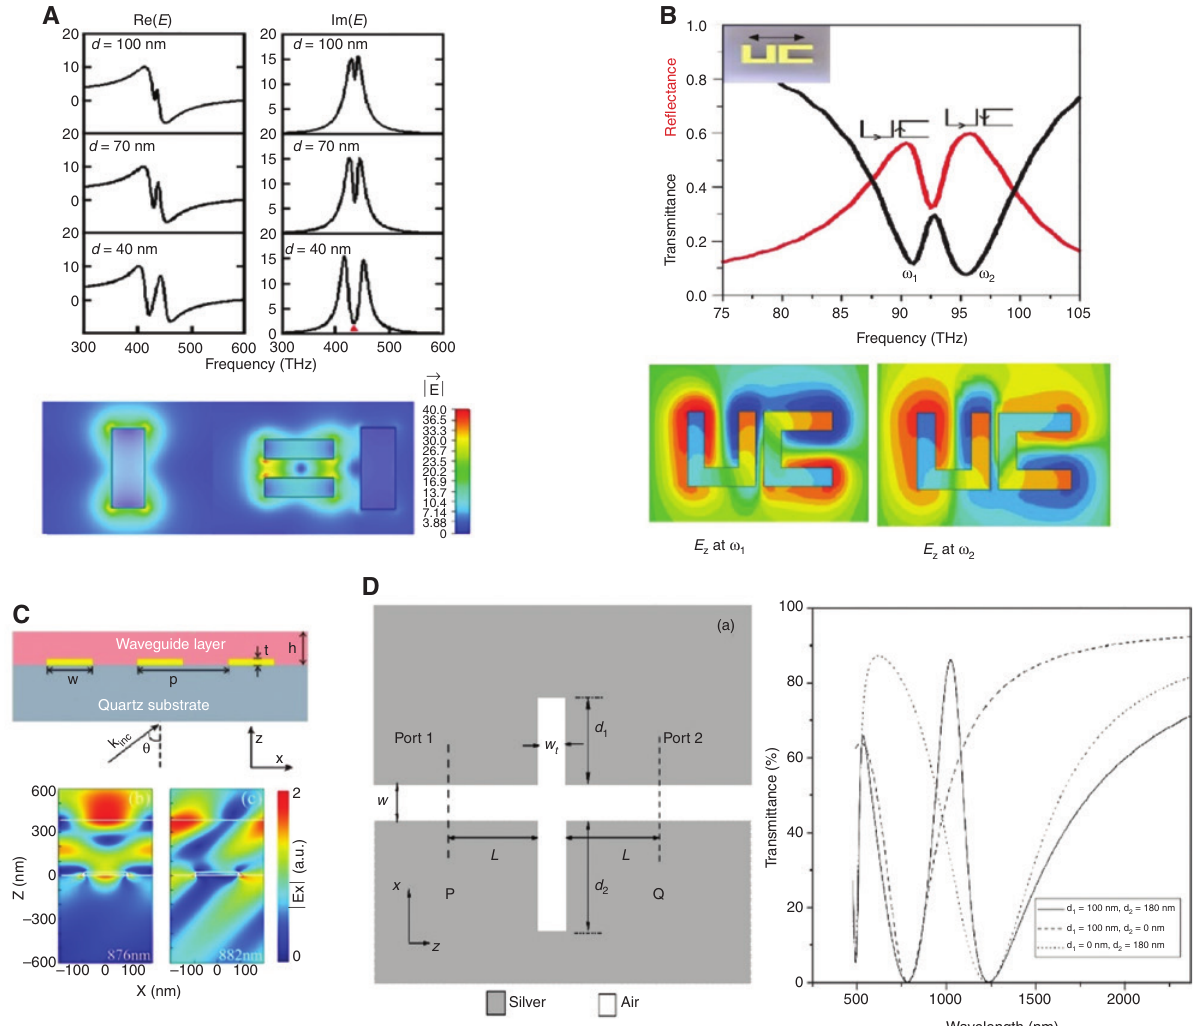
Figure 1: Transmission spectrum and near-field distribution of the PIT effect. (A) A π -shaped structure containing metal nanorods as building blocks. The real and imaginary parts of the electric field spectra indicate that PIT phenomena can be tuned by changing the gap distance between bright and dark resonators. The 2D field plot of electric field distribution indicates the bright and dark modes [24]. (B) Asymmetric SRRs supporting magnetoinductive or electroinductive coupling. Simulated transmittance and reflectance spectra of the asymmetric SRRs indicate a PIT transparent window at 93 THz. The electric field distributions at resonances ω and ω of the PIT structure are also provided [25]. (C) Schematic illustration of the hybrid PIT structure 1 2 illuminated by a light with an incident angle of θ . The simulated field distributions at PIT range indicate the metallic nanogratings and the dielectric cover layer provide the bright and dark modes, respectively [26]. (D) Schematic of an in-plane coupling PIT structure composed of double-sided teeth-shaped nanocavities and plasmonic waveguide. By optimizing the length of the two nanocavities d window can be shown at about 1000 nm [27]. (a) Reproduced with permission from Ref. [24]. Copyright 2008 American Physical Society. (b) Reproduced with permission from Ref. [25]. Copyright 2008 Wiley. (c) Reproduced with permission from Ref. [26]. Copyright 2011 AIP. (d) Reproduced with permission from Ref. [27]. Copyright 2010